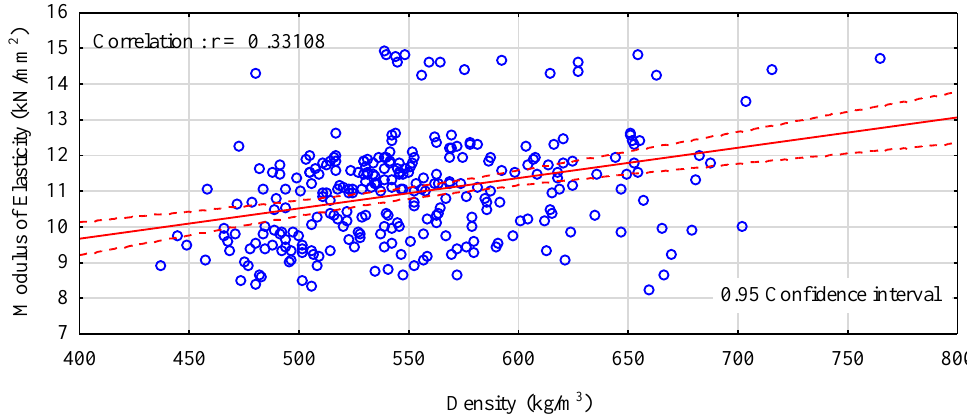
Figure 6. A correlation between density and the modulus of elasticity determined in a four-point bending test.